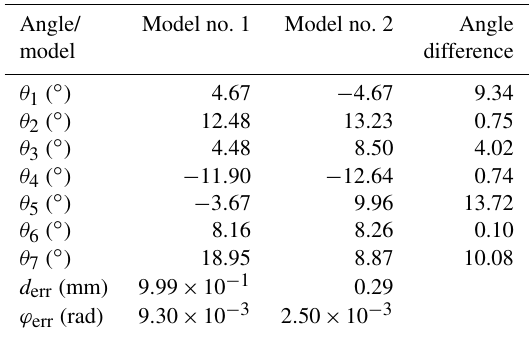
Table 4. Joint angle interval of the third and fourth models.